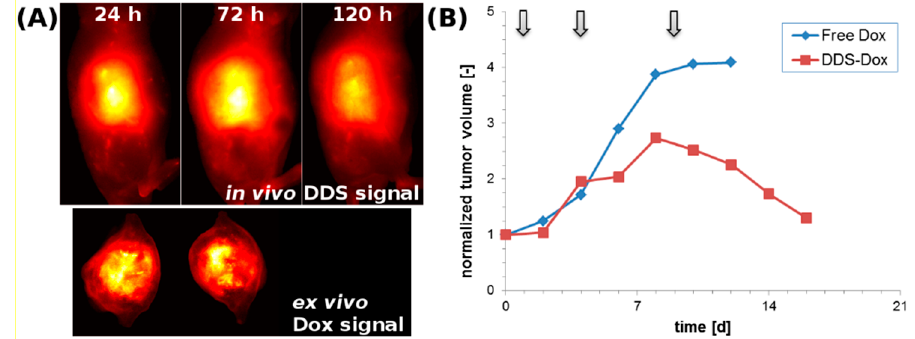
Figure 9. ( A ) Top, lateral mouse images of a subcutaneous growing xenograft tumor 24, 72, and 120 h after the first drug delivery system (DDS) administration. The in vivo tumor accumulation of the NIR fluorescently labeled DDS (containing Dox attached via a pH-sensitive hydrazone bond) is clearly visible (yellow to white area). Bottom, a tumor cross-section showing a central area with high Dox accumulation. ( B ) The plot displays data from mice bearing a Dox-resistant subcutaneous xenograft tumor treated with free Dox (blue curve) or with the DDS loaded with Dox (red curve). Therapy application is indicated by the grey arrows. It is clear that free Dox cannot initiate tumor regression, whereas DDS-delivered Dox can significantly reduce tumor volume after the third injection. This remission is induced by therapeutic intratumoral Dox levels caused by the enhanced permeability and retention e ff ect-based DDS accumulation. Reprinted with permission from [5], Copyright [2016], Elsevier.) Potential of poly(ethylene glycol)-block-poly( d , l -lactic acid) (PEG-b-PLA) micelles carrying